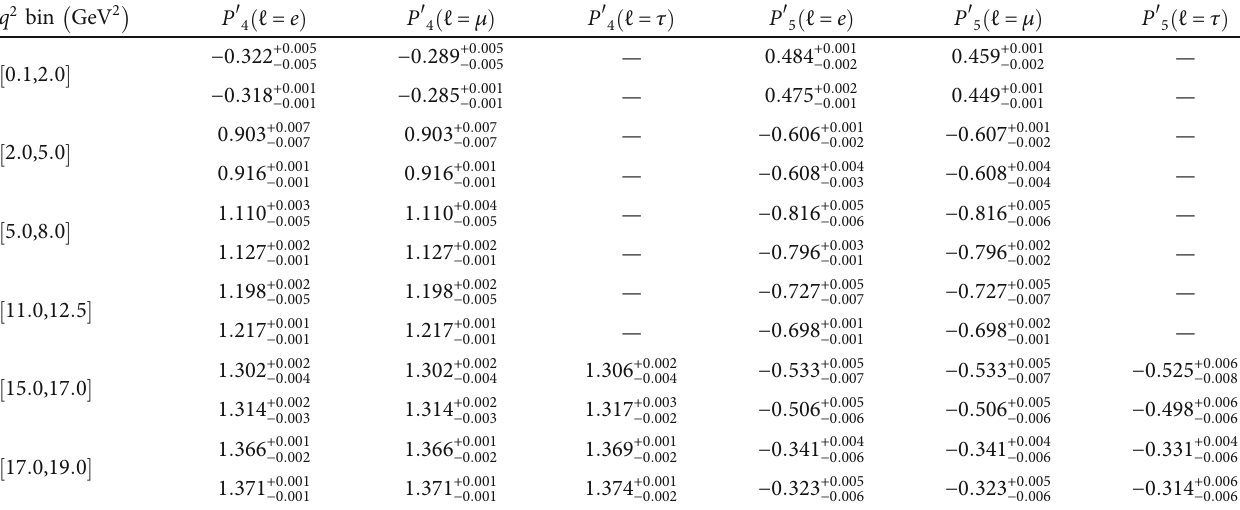
′ ⟶ ϕ ℓ + ℓ − with ℓ = ð e , μ , τ Þ in the 4 and P 5 of the decays B s